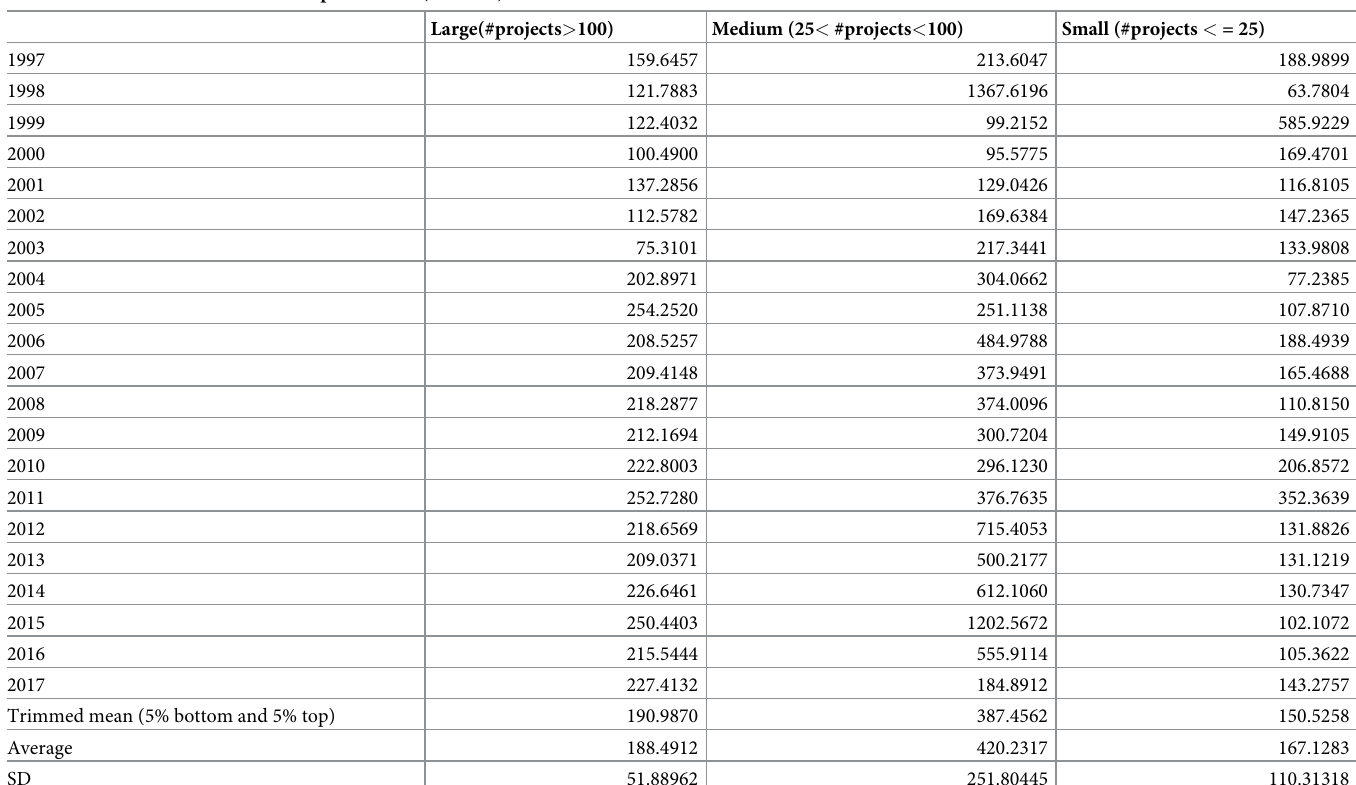
Table 8. Number of source code lines per commit